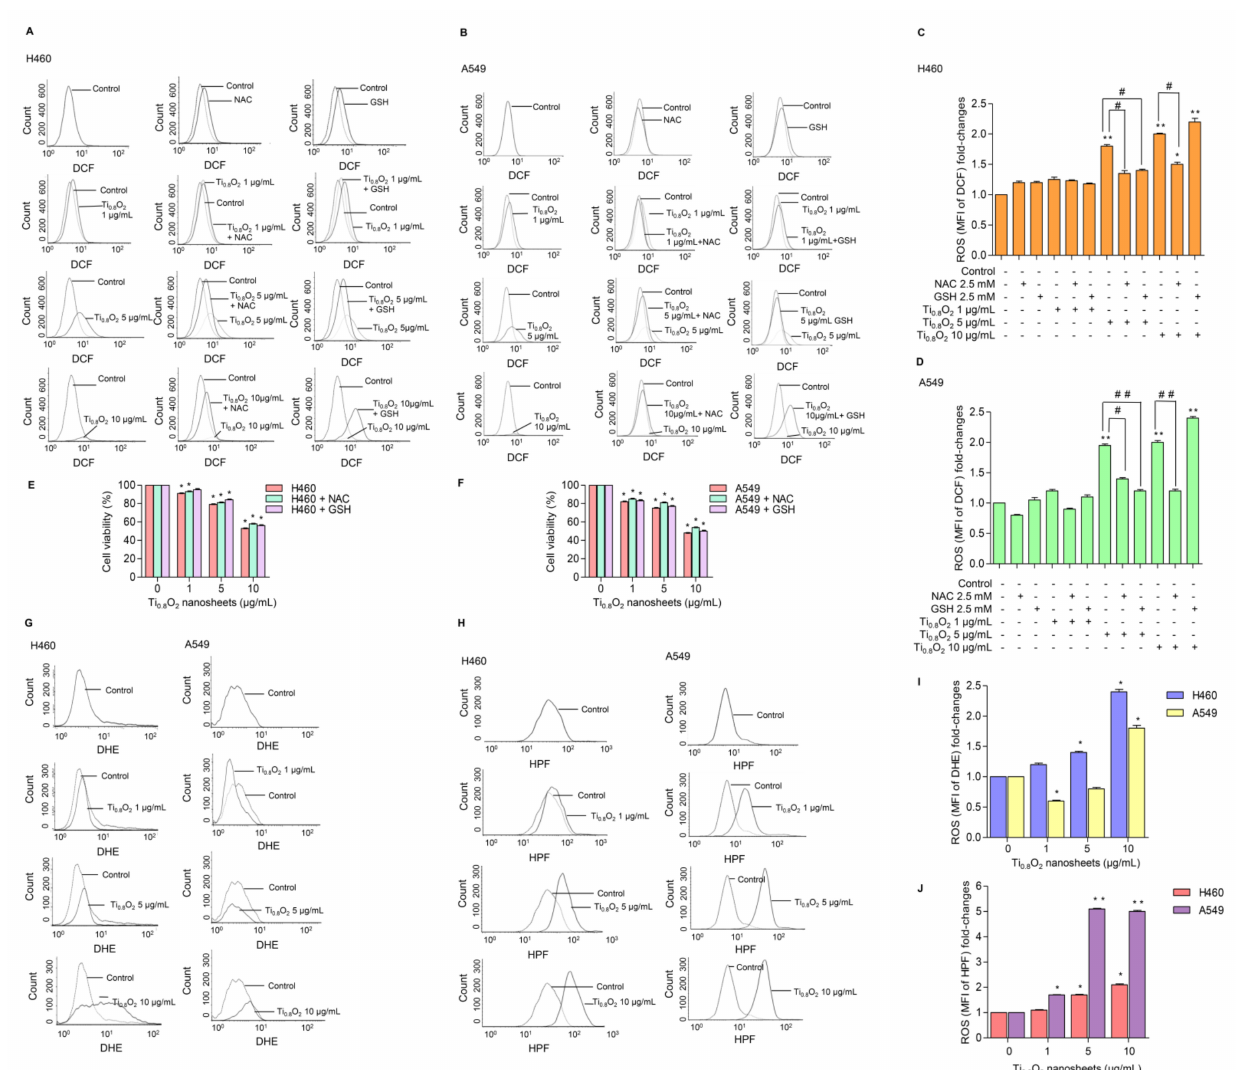
Figure 5. Ti 0.8 O 2 nanosheets induced intracellular ROS in H460 and A549 cells. ( A – D ) The effect of Ti 0.8 O 2 nanosheets (0–10 g/mL) on intracellular ROS induction at 24 h in H460 and A549 cells was determined by flow cytometry with the fluorescent probe DCF (10 µ M). Cells were treated with Ti 0.8 O 2 nanosheets (0–10 µ g/mL) alone for 24 h or with the pretreatment of 2.5 mM NAC and 2.5 mM GSH. ROS levels were calculated and presented as the mean fluorescence intensity (MFI); ( E , F ) effect of Ti 0.8 O 2 nanosheets on cell viability in H460 and A549 cells at 24h with the pretreatment of 2.5 mM NAC or 2.5 mM GSH was determined by an MTT assay. Data are shown as the mean ± SEM ( n = 3); ( G , I ) the effect of Ti 0.8 O 2 nanosheets (0–10 µ g/mL) on superoxide anion induction at 24 h in H460 and A549 cells was determined by flow cytometry with the fluorescent probe DHE (10 µ M). Superoxide anion levels were presented as mean fluorescence intensity (MFI); ( H , J ) the effect of Ti 0.8 O 2 nanosheets (0–10 µ g/mL) on hydroxyl radical induction at 24 h in H460 and A549 cells was determined by flow cytometry with the fluorescent probe HPF (10 µ M). Hydroxyl radical levels were calculated and indicated as the mean fluorescence intensity (MFI). All data are shown as the mean ± SEM ( n = 3). * p < 0.05, ** p < 0.01 compared with the untreated control, and # p < 0.05, ## p < 0.01 compared with the treated cells at the same concentration of Ti 0.8 O 2